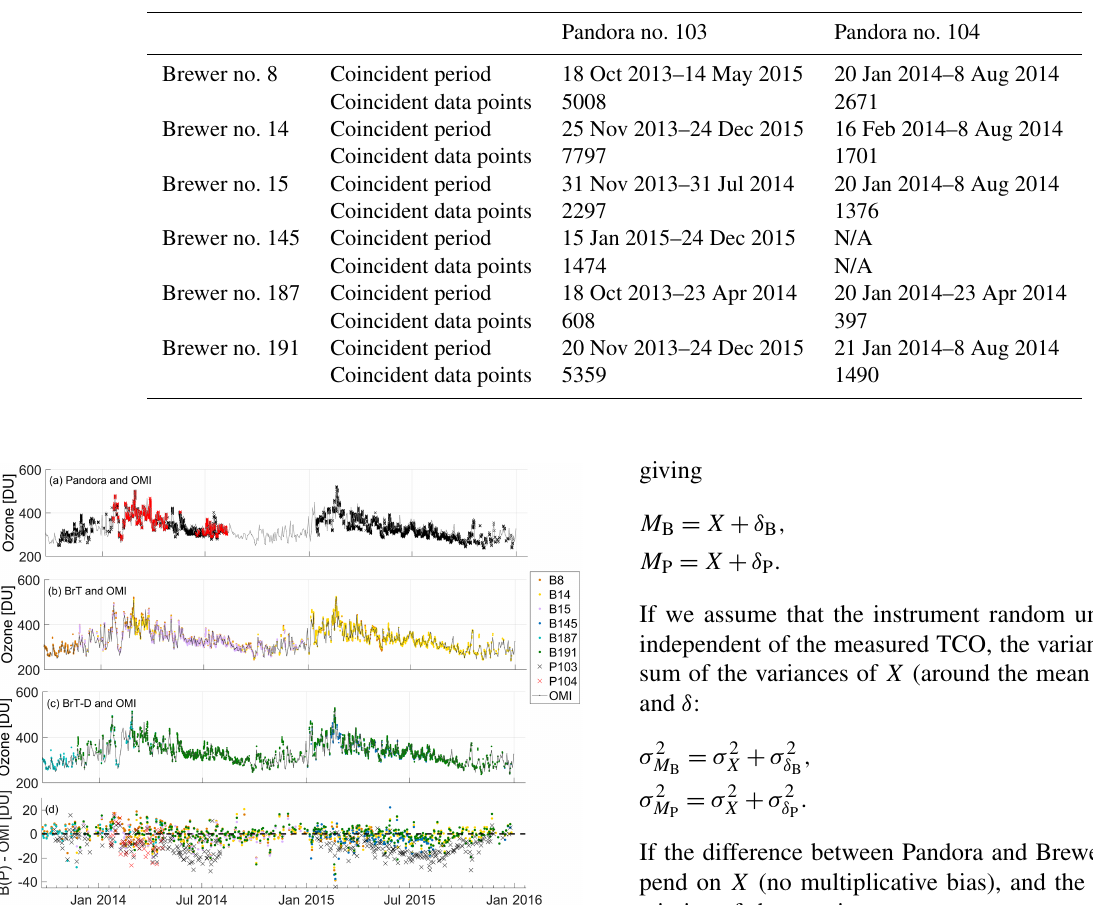
Table 1. Coincident measurement periods and number of data points for comparisons between Pandora and Brewer instruments.